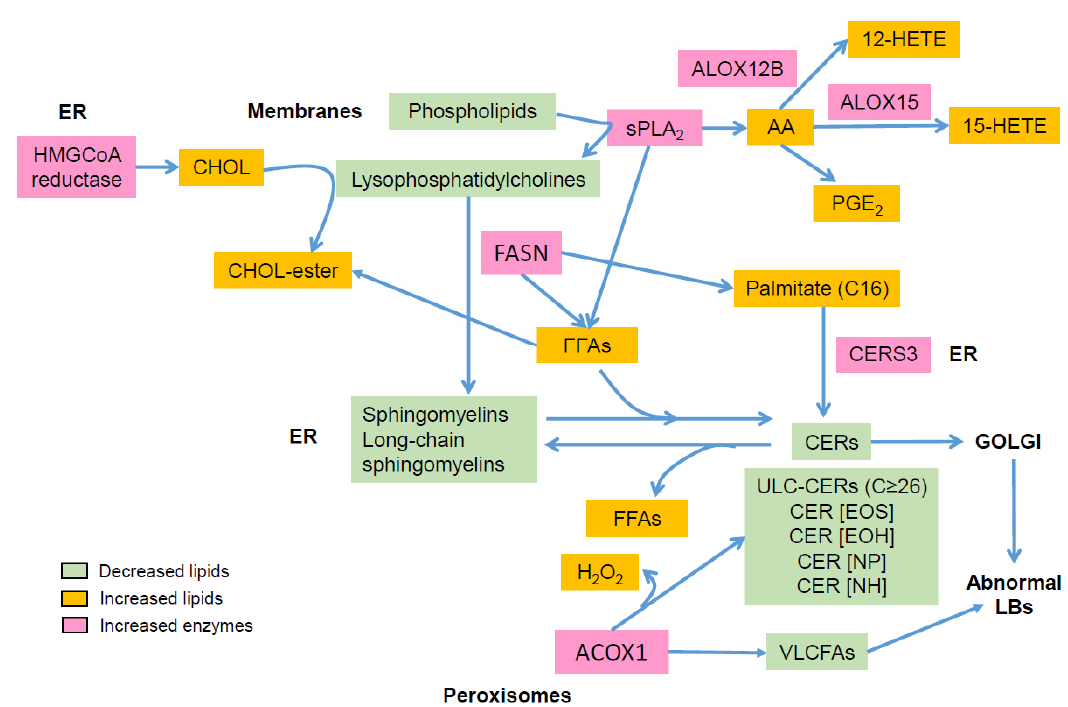
Figure 2. Main alterations in epidermal lipid composition in atopic dermatitis: AA: arachidonic acid;